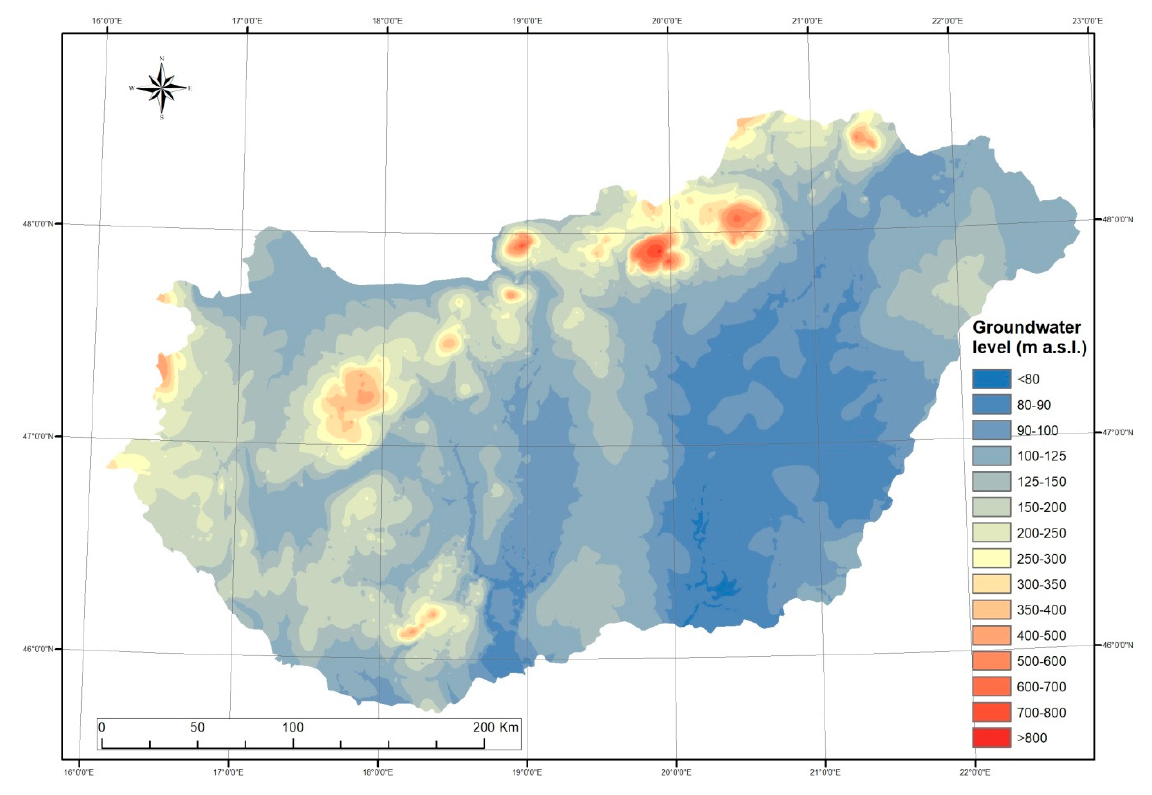
Figure 15. Simulated groundwater table: 1961–1965 average conditions.